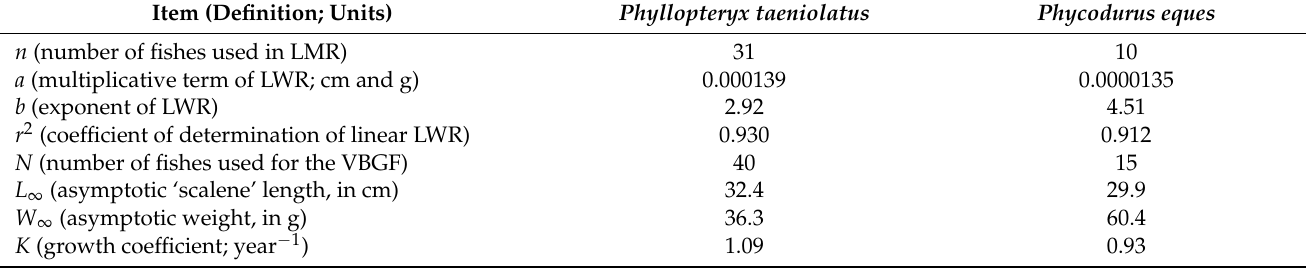
Table 4. Parameters of the length–weight relationship (LWR) and of the von Bertalanffy growth function (VBGF) estimated for the data in Tables 1 and 2, with both sexes combined.